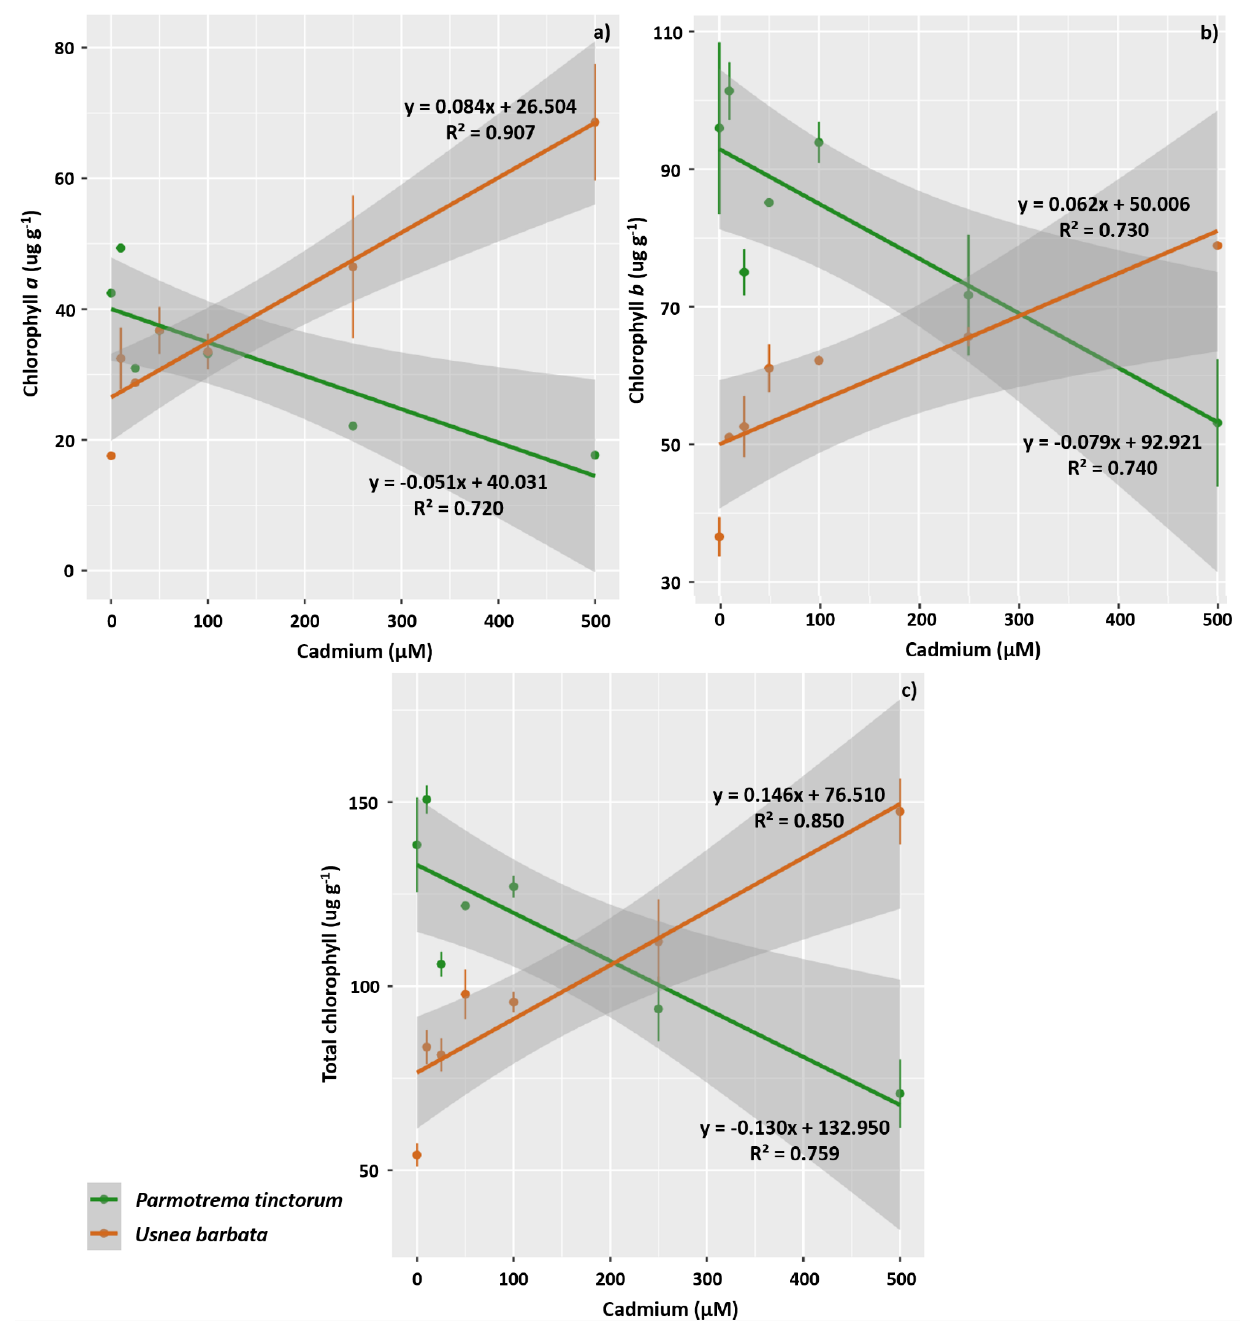
Figure 4. Photosynthetic pigment concentrations chlorophyll a ( a ), chlorophyll b ( b ), and total chlorophyll ( c ) observed for the photobionts of the lichen species Parmotrema tinctorum and Usnea barbata subjected to different concentrations of Cd (0, 10, 25, 50, 100, 250, and 500 µM). The straight lines represent the fitted model, and the prediction intervals (95%) are gray.